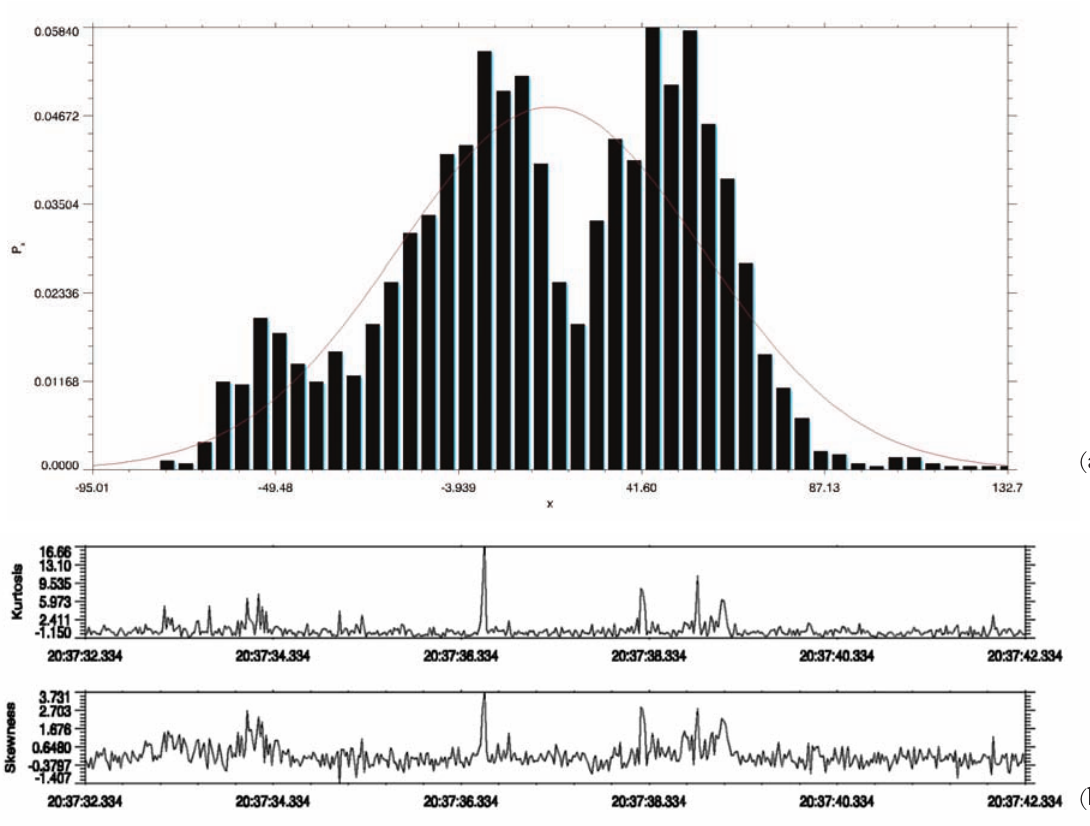
Figure 3. (a) Probability distribution function of the electric field intensity variations for the same time interval as in Figure 2. (b) Evolution of the kurtosis and skewness of the PDF between 20:37:32 and 20:37:42 UT.